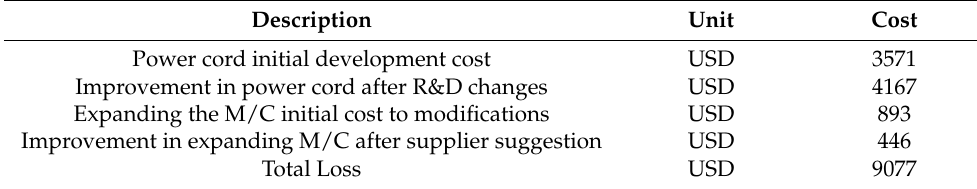
Table 11. Amounts lost due to the lack of stakeholders’ involvement.